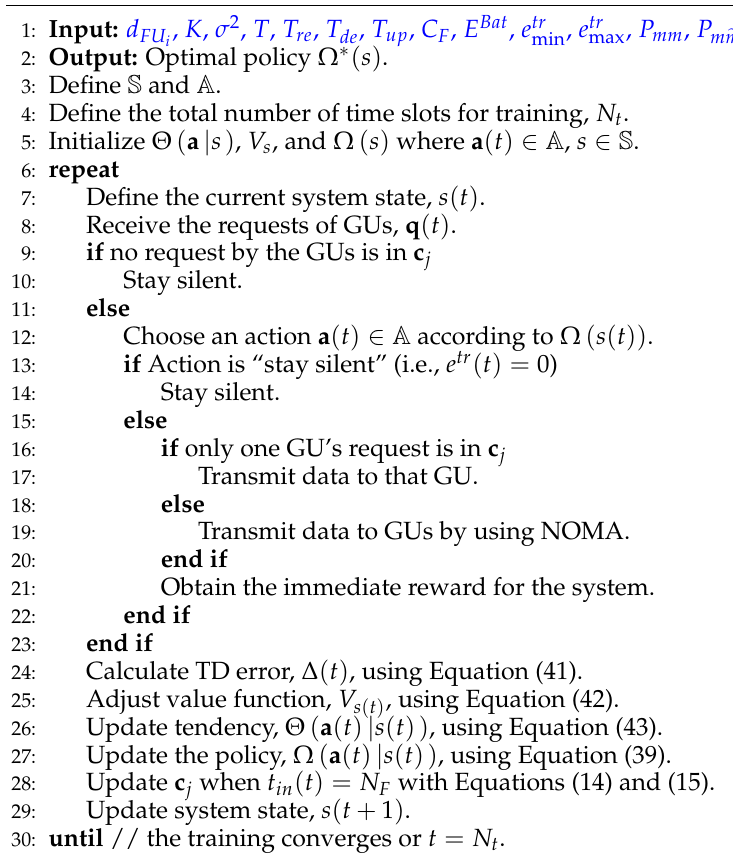
Algorithm 2 The detailed training process of the UAV using the proposed actor-critic-based